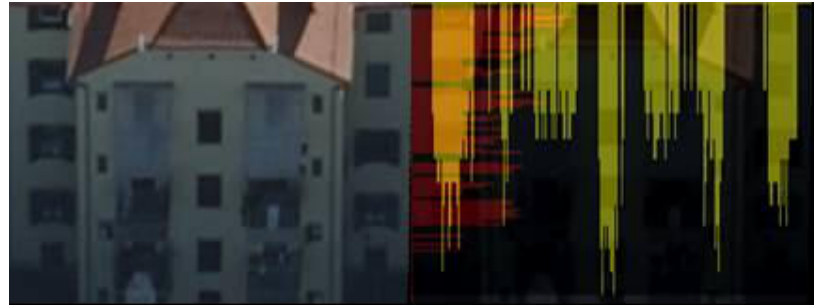
Figure 16. To the left is a rectified facade image with its depth structure. To the right is a failed count of windows using the workflow that assumes that a facade is in a single